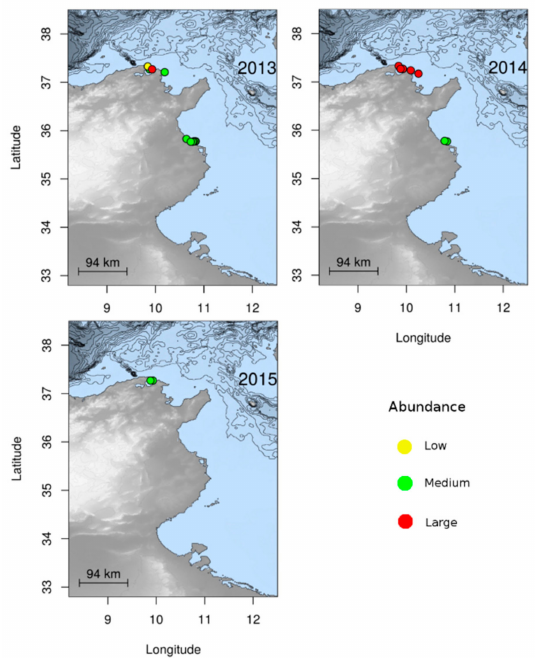
Figure 11. Spatial distribution of jellyfish reports from 2013 (upper-left panel) to 2015 (lower-left panel) for Pelagia noctiluca in Tunisia. Abundance categories are shown as follows: category 1—“low” in yellow, category 2—“medium” in green, and category 3—“high” in